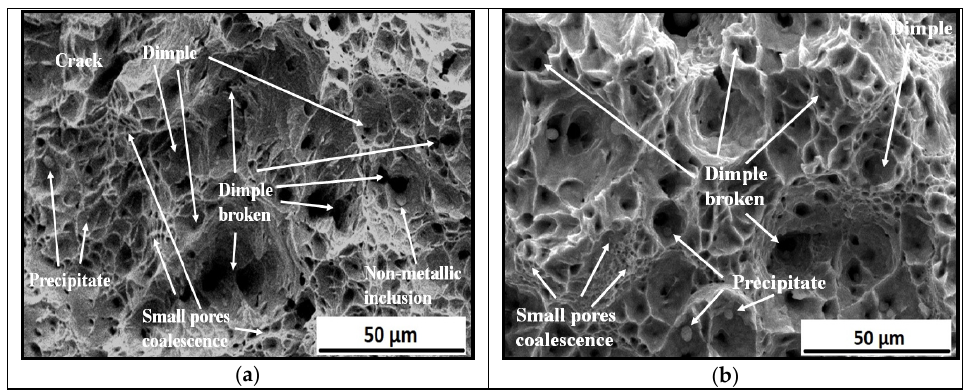
Figure 7. Stress strain curve of M9.8 WQ/aged samples with different holding time 60 min, 120 min and 240 min.